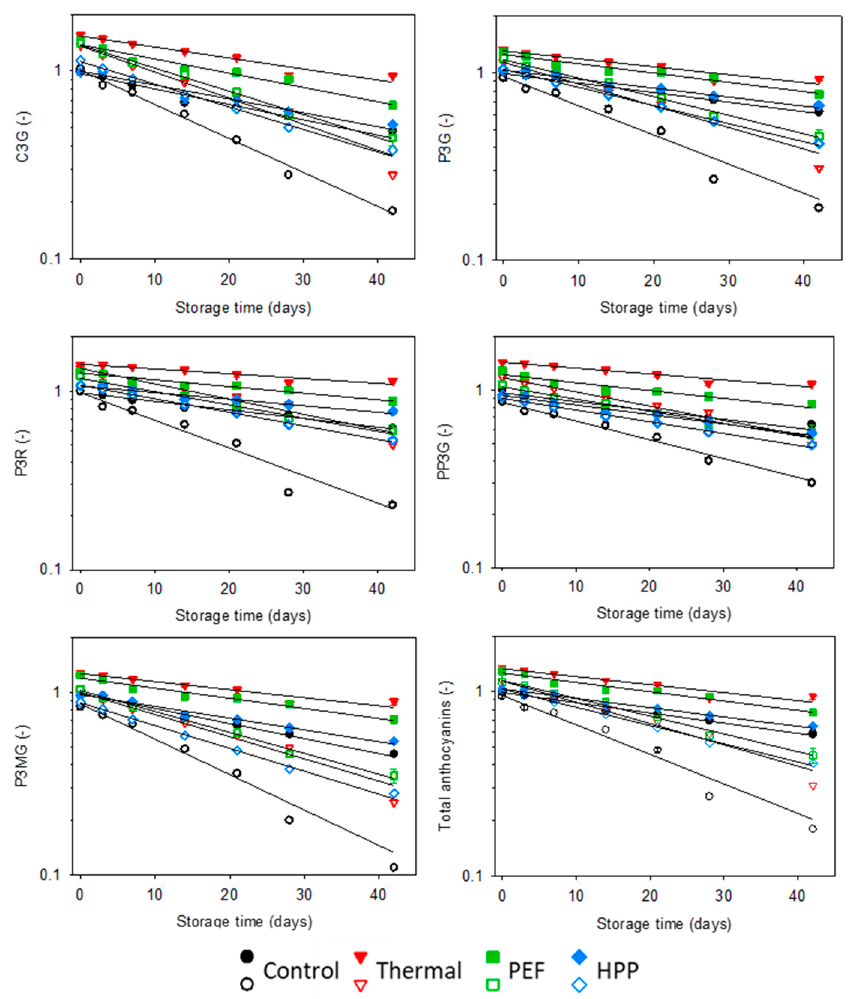
Figure 6. Kinetic modelling for the relative anthocyanin contents in the aqueous phase measured via HPLC-DAD during refrigerated storage at 4 °C for the strawberry-kale mix (empty) and strawberry-water (filled) (n = 3).